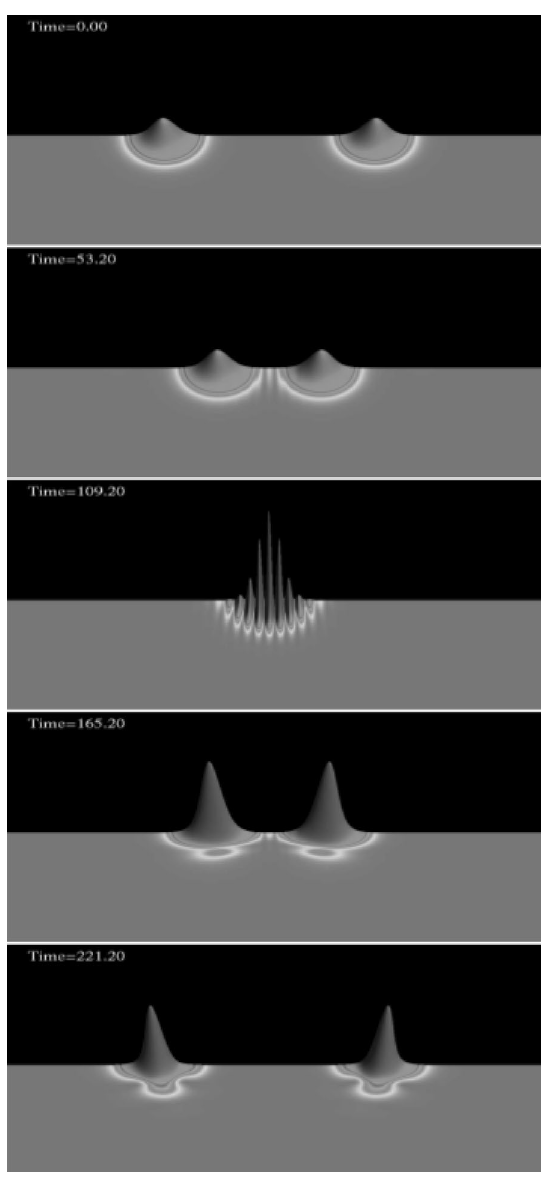
Fig. 1 Demonstration of the solitonic nature of the (mini- )boson star. Shown are snapshots of the magnitude squared of the complex scalar fi eld for a head- on collision of two identical mini-boson stars. The interacting stars display an interference pattern as they pass through each other, recovering their individual identities after the collision. However, note that the BSs have a larger amplitude after their interaction and so are not true solitons. The collision can therefore be considered inelastic